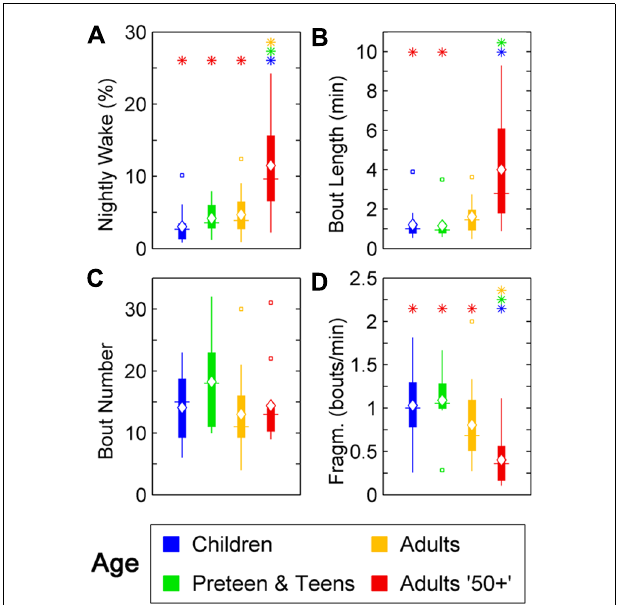
FIGURE 2 |Wake parameters of nightly sleep in humans across age groups: Children (blue), Preteens and teens (green),Adults (orange), andAdults 50 + (red). Colored asterisks above bars indicate a statistically significant difference between the bar group and the group with the corresponding color of the asterisk. (A) Percentage wake time.The mean percentage of time awake is significantly lower for Adults over 50 than for all other age groups. (B) Mean wake bout duration. Adults over 50 have significantly longer wake bouts during the night than Children and Preteens and teens. (C) The number of wake bouts do not change with age. (D) Wake bout fragmentation (bouts/min). Adults over 50 show significantly less fragmented wake than the younger age groups. Diamond, white line, and squares indicate mean, median, and outlier values, respectively.